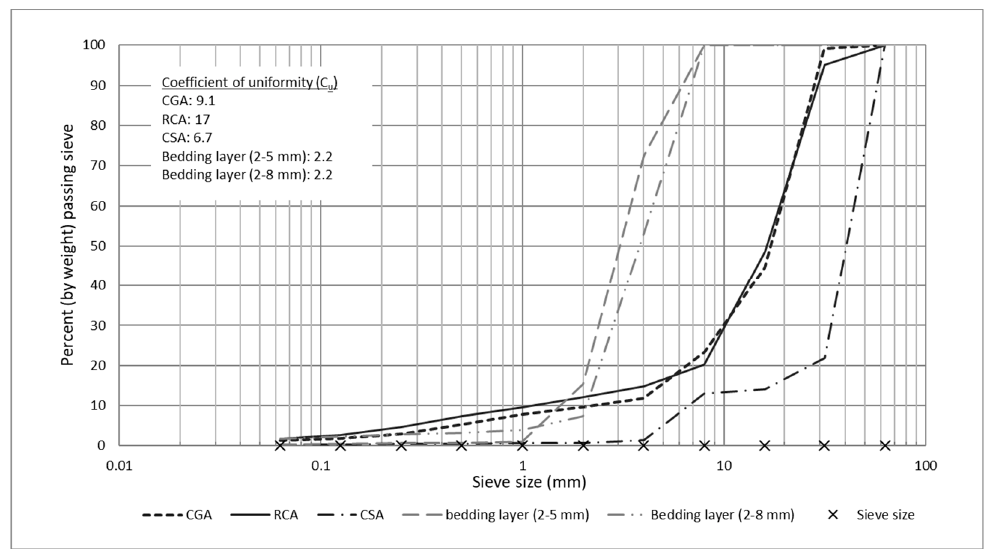
Figure 3. Particle size distribution of sub-base aggregates used in the six stalls and their coefficients of uniformity (C u ). CGA = crushed gravel aggregates; RCA = recycled concrete aggregates; and CSA = crushed stone aggregates. The sieves ranging from 0.063 to 63 mm according to DS/EN 993-1 are marked with an X on the horizontal axis. Table 1. Storage capacities of sub-base aggregates used in the test. CGA = crushed gravel aggregates; RCA = recycled concrete aggregates; and CSA = crushed stone aggregates.